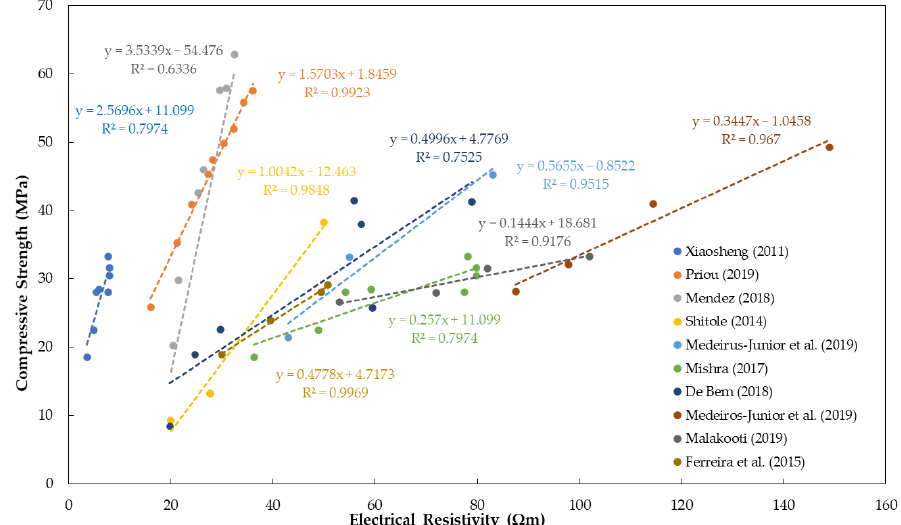
Figure 8. Summary of references showing the relationship between electrical resistivity and compres- sive strength.